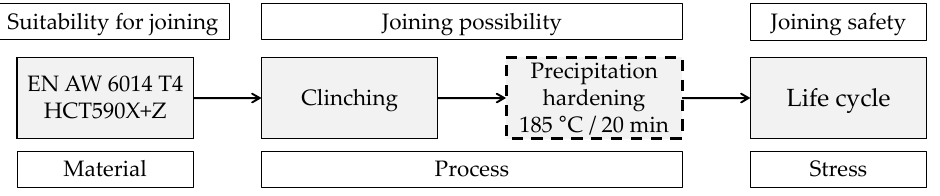
Figure 1. Production process clinching of Al-Steel components.